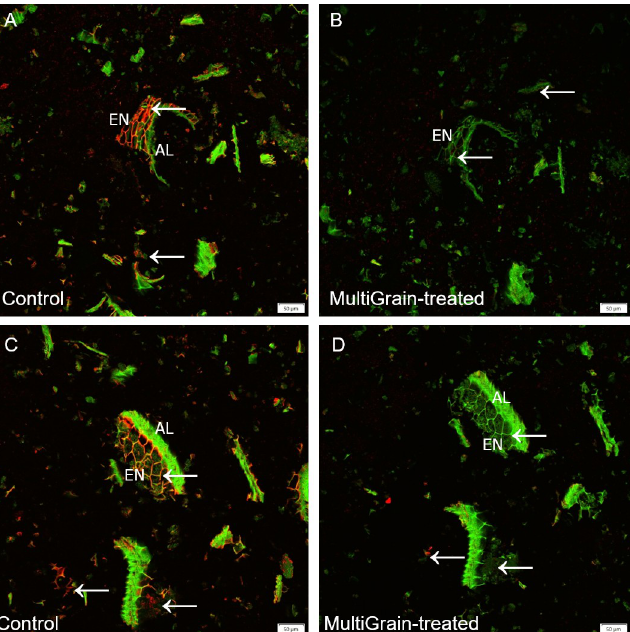
Fig 6. Confocal images of cross sections of DORB. Section of samples incubated (A, C) with sodium acetate buffer (control) or (B, D) with MultiGrain for 3 hours at pH 5. The sections were subsequently (A, B) incubated with the LM28 antibody detecting arabinoxylans and the red-fluorescence labelled secondary antibody or (C, D) incubated with the LM25 antibody detecting xyloglucans with different branching structures and the red-fluorescence labelled secondary antibody. Red signal indicates (A, B) glucuronoarabinoxylans and (C, D) xyloglucans and the green signal indicates autofluorescence. AL = aleurone; EN = starchy endosperm. Arrows point to sites where the fluorescence signal due to staining or immunolabelling is present and removed following treatment with MultiGrain. (A-D) Scale bar = 50 μ m.